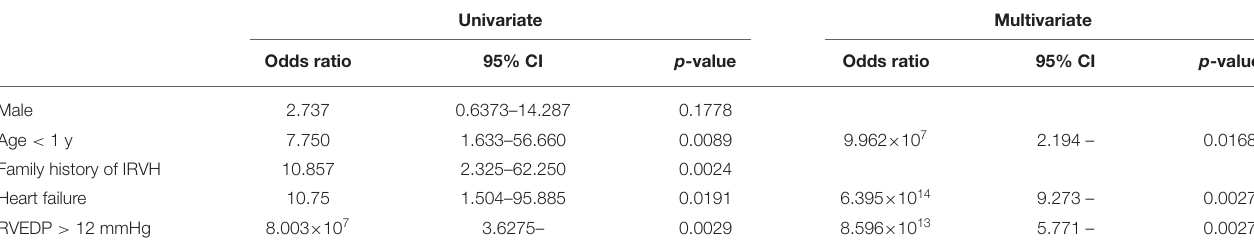
TABLE 4 | Univariable and multivariable logistic regression analyses for independent predictors of mortality. Univariate Multivariate Odds ratio 95% CI p -value Odds ratio 95% CI p -value 2.737 0.6373–14.287